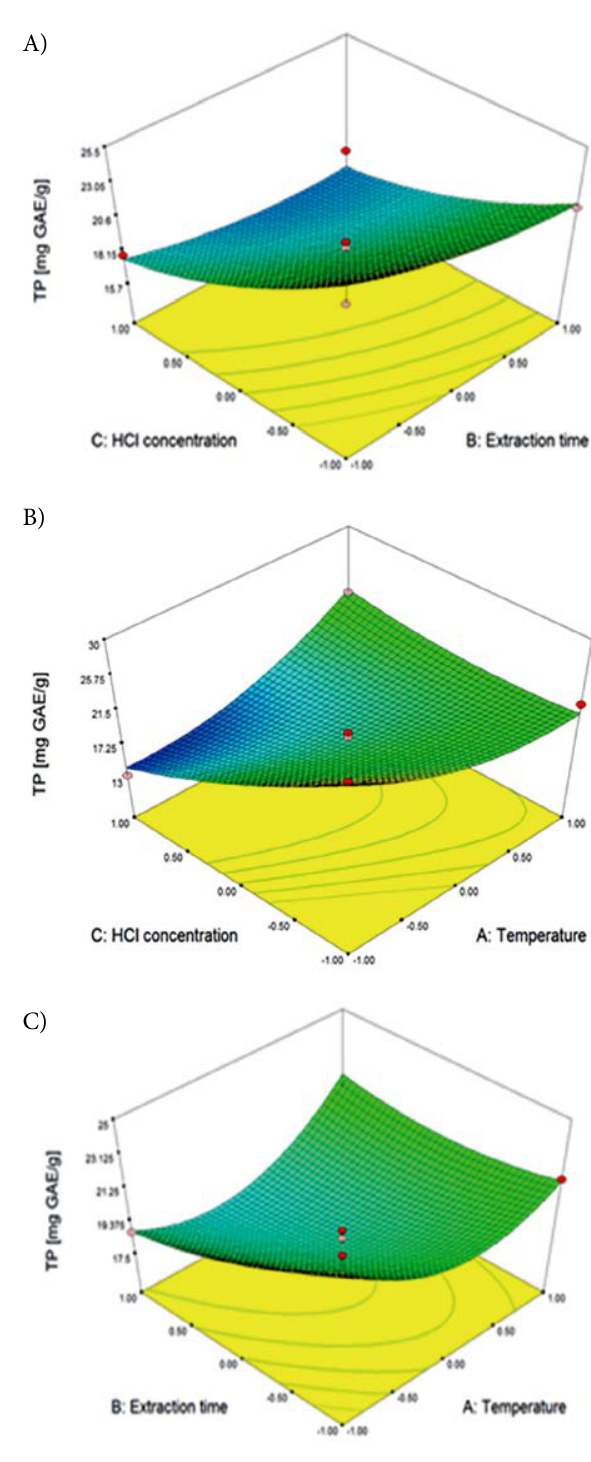
Figure 2. Response surface plots showing combined effects of pro- cess variables: (A) HCl concentration and extraction time, (B) HCl concentration and temperature and (C) extraction time and tem- perature on total phenolics